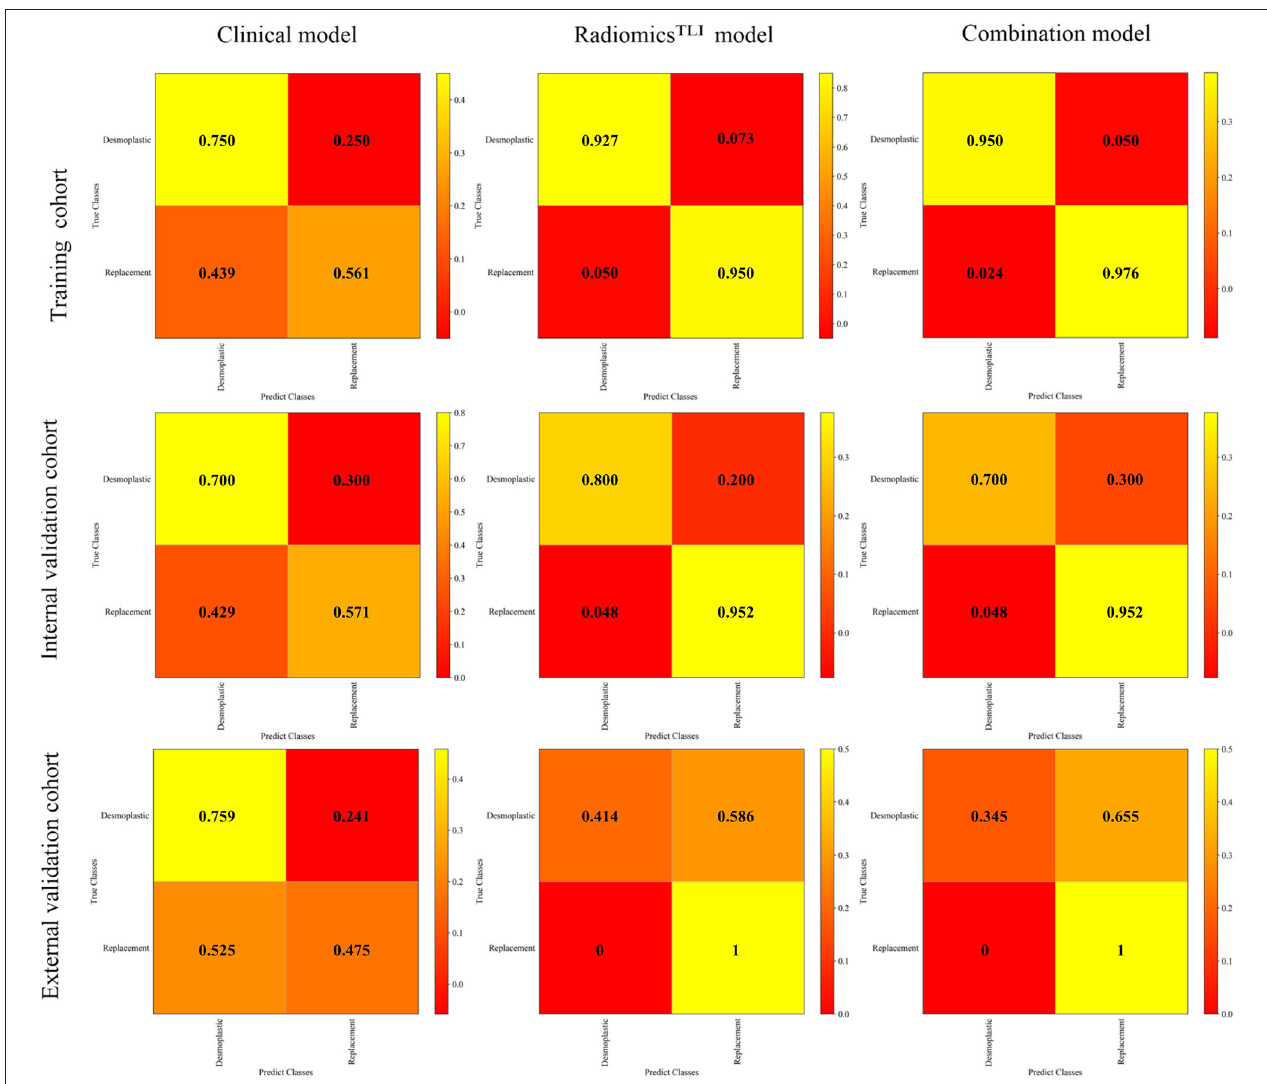
FIGURE 4 | Confusion matrixes for clinical, radiomics TLI , and combination model in all